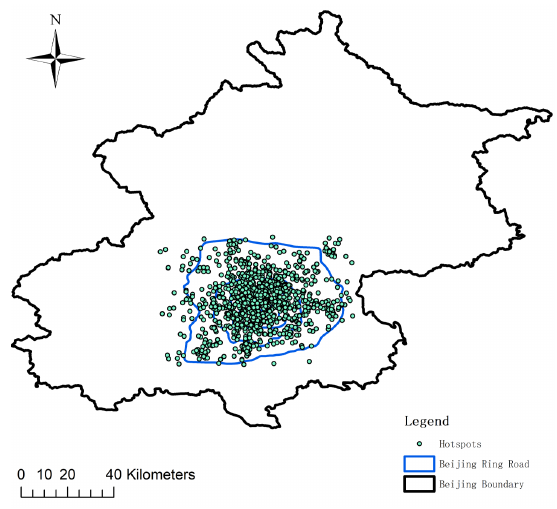
Figure 2. Distribution of major hotspot locations in Beijing. Table 1. Classification table of major hotspot locations in Beijing.